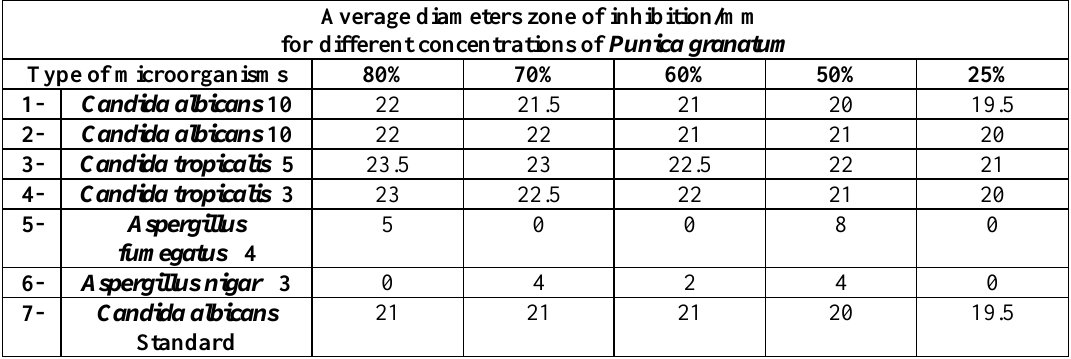
Table(2) –Diameters Zone of Inhibition /mm of Fungi Under test (Ethanol Extracts ) Average diameters zone of inhibition/mm